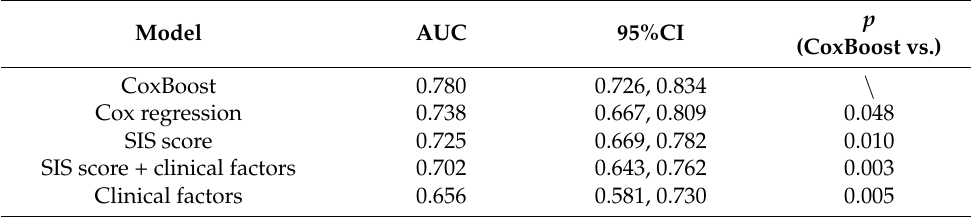
Figure 5. The AUC of each model in testing dataset over 30 months. Over an approximately three- year period, compared to the AUC of other models (Cox regression, SIS score, SIS score + clinical factors, and clinical factors), the AUC of ML model for prediction of MACE was significantly increased [AUC(CI): 0.780 (0.726, 0.834), 0.738 (0.667, 0.809), 0.725 (0.669, 0.782), 0.702 (0.643, 0.762), 0.656 (0.581, 0.730), p < 0.05]. Table 4. Comparison of AUC for each model validated at 30 months of